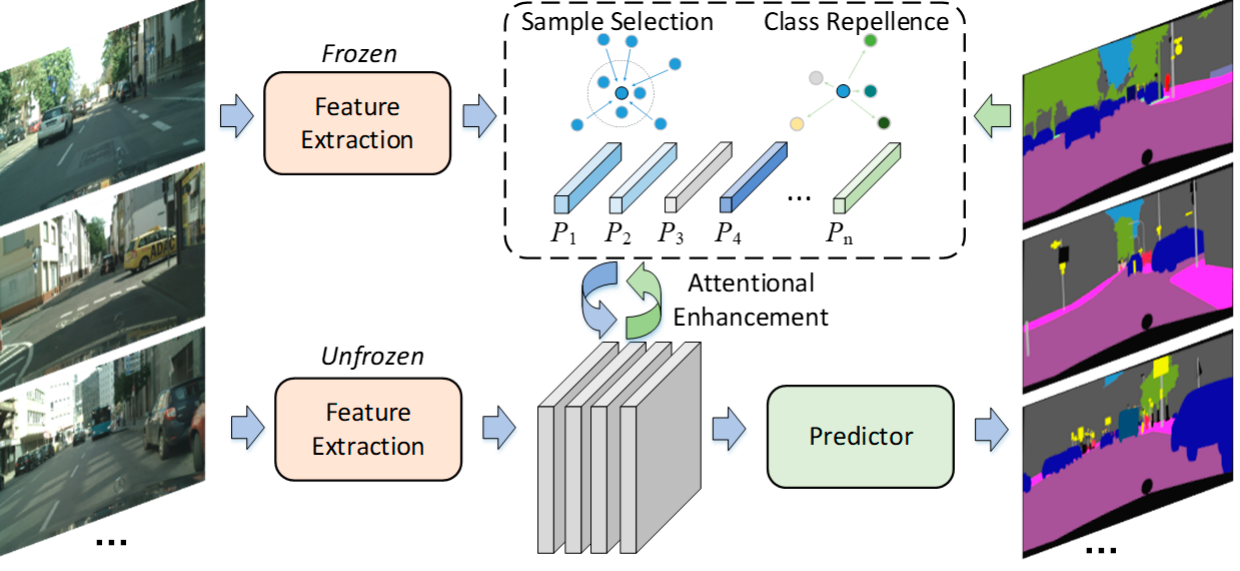
Figure 1. The flowchart of APMNet.